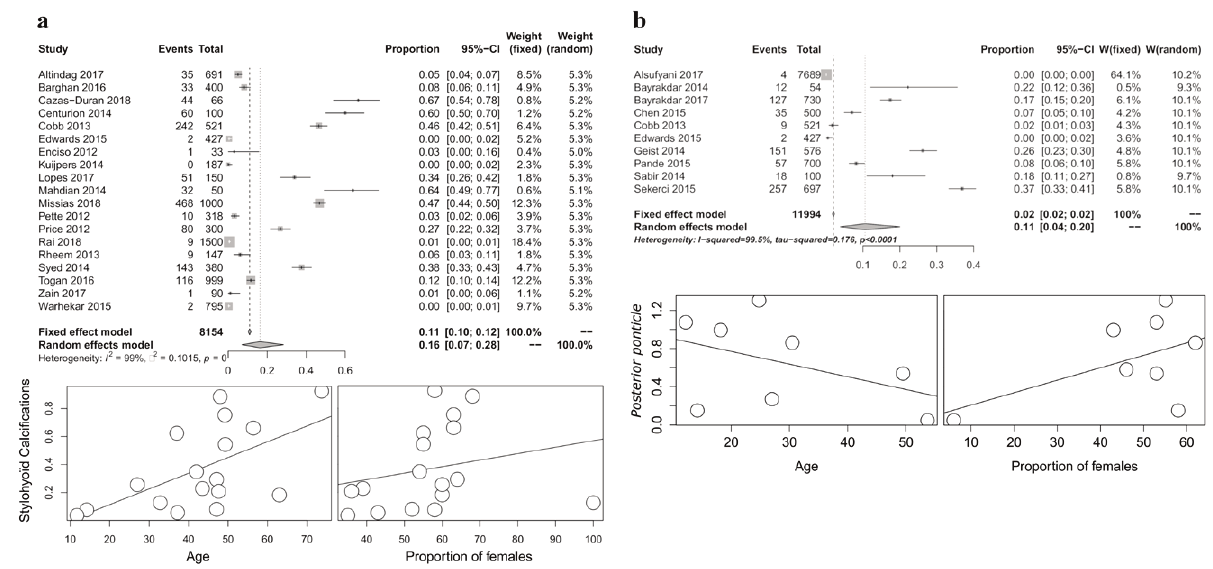
Figure 2: Meta-analysis on prevalence data about stylohyoid ligament calcifications (SHL) and Posterior ponticle (PP). Part a, upper. Forest plot of the meta-analysis on prevalence data. An event was defined as the presence of at least one SHL calcification. The mean fixed and random model global prevalence is provided, together with heterogeneity. Part a, lower. Meta-regression plot of the linear relationship between the prevalence of SHL calcifications, the mean age of patients (significant) and the proportion of females (not significant). Part b, upper. Forest plot of the meta-analysis on prevalence data. An event was defined as the presence of at least one PP, partial or complete. Part b, lower. Meta-regression plot demonstrated no linear relationship with the mean age of patients and proportion of